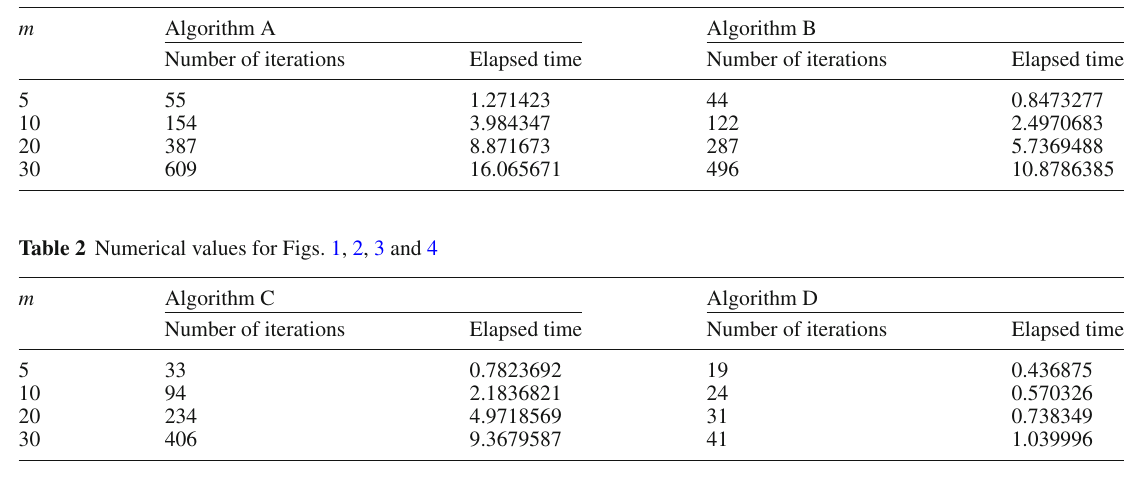
Table 3 Example 4.2: Numerical study of Algorithm 1 in [16] and u 0 = u 1 = ( 1 , 2 , 5 , 4 ) T Iter ( n